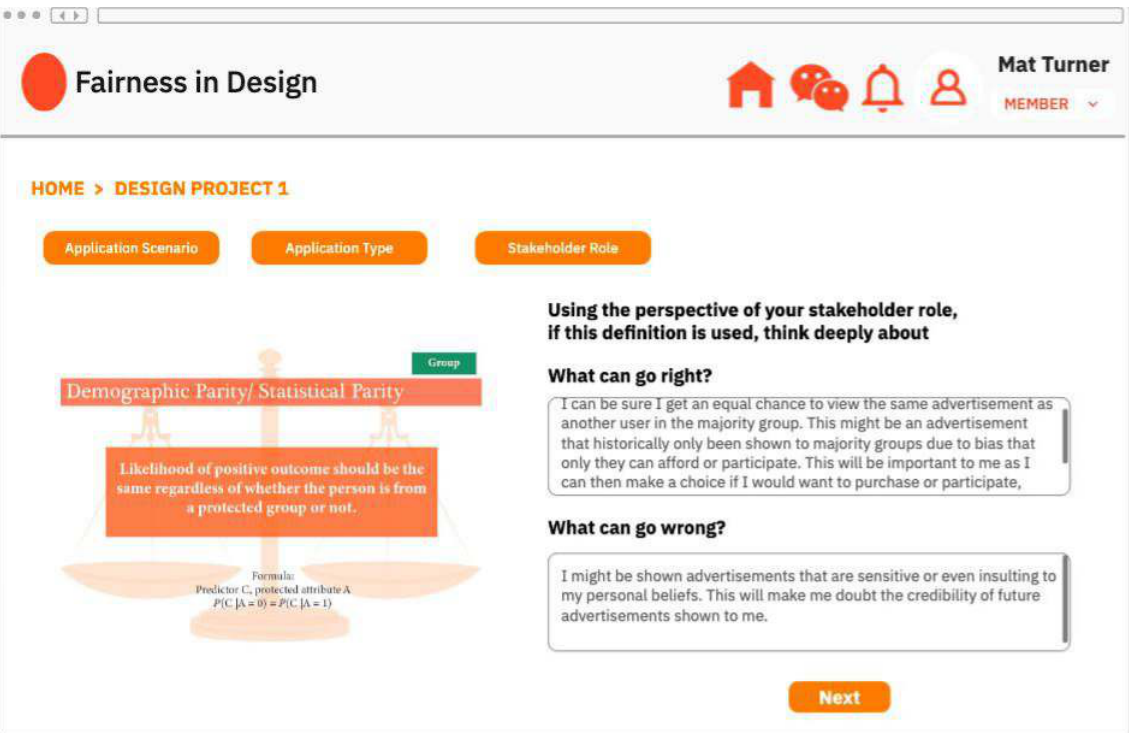
Fig. 2 An example user interface of FID (writing an envisioned stakeholder review for the given fairness notion—demographic